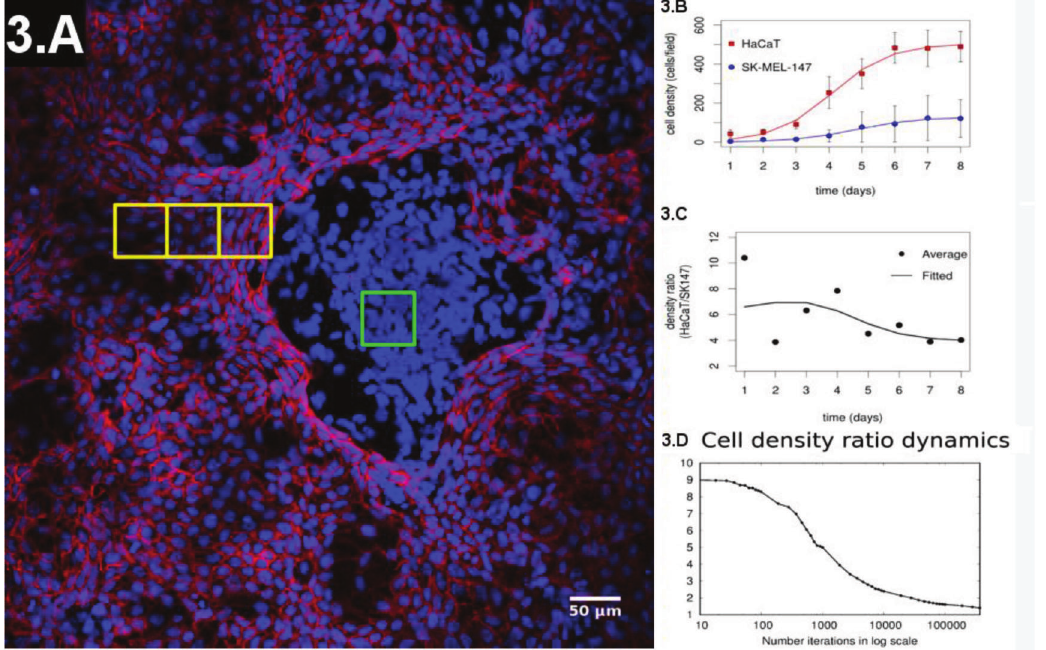
Figure 3 - ( A ) Representative configuration of the co-culture experiment at the confluence regime. ( B ) Evolution of the individual populations until confluence is reached and their fitting by a sigmoidal curve. ( C ) Experimental ratio of melanoma to normal cells over time. ( D ) Simulation of the ratio of melanoma to normal cells over